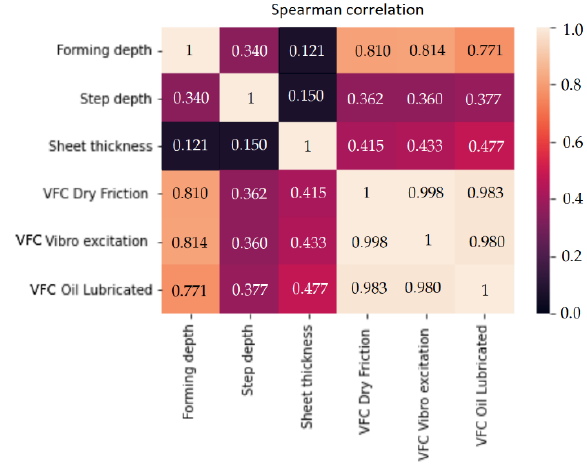
Figure 6. Spearman correlation matrix and r coefficient.